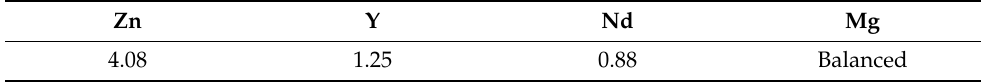
Table 1. Chemical composition of the as-fabricated Mg–Zn–Y–Nd alloy (wt. %). Zn Y